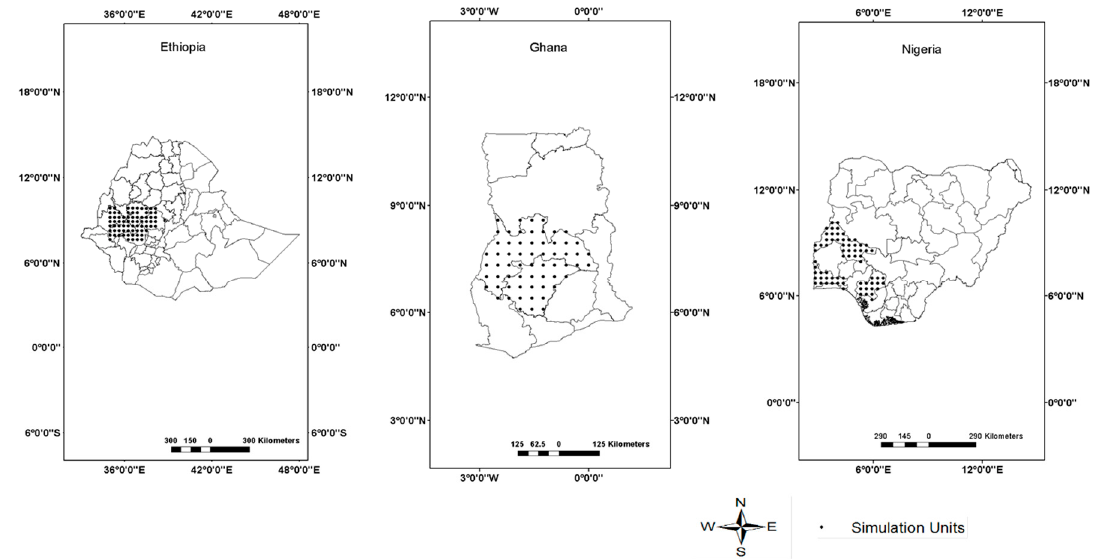
Figure 3. Map showing simulation units in Ethiopia, Ghana and Nigeria.